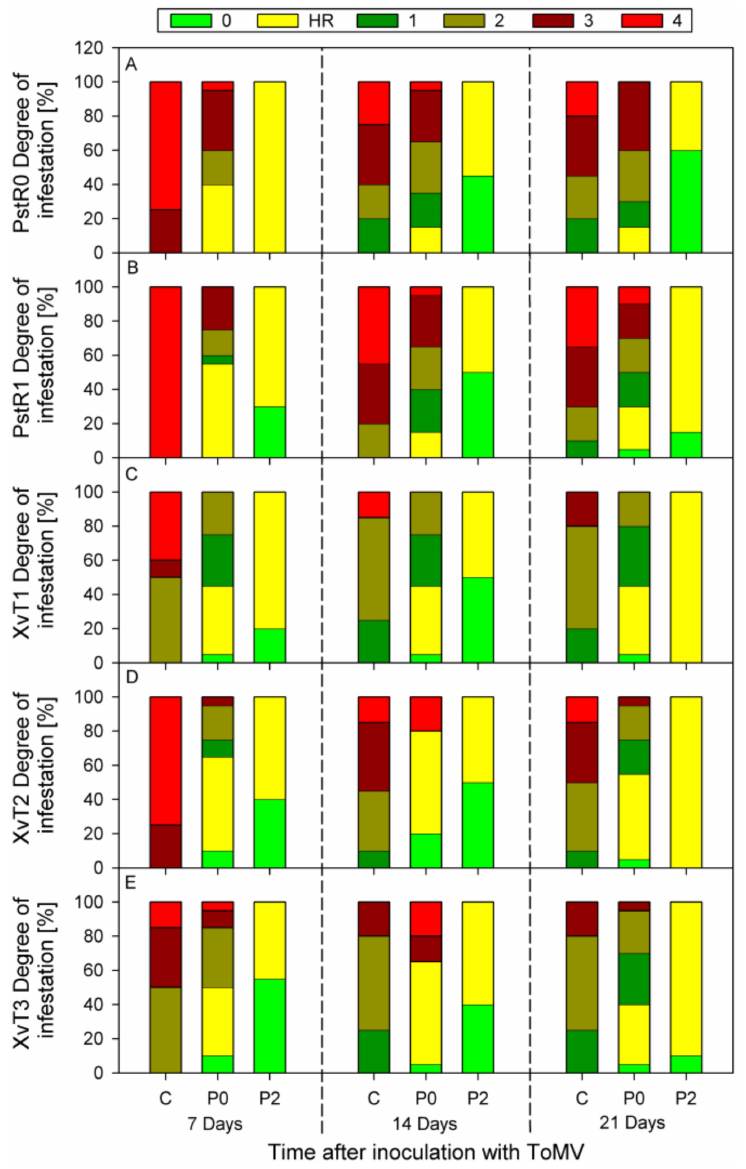
Figure 1. Degree of infestation from Pst (R0, R1) and Xv (T1, T2, T3) on tomato plants cv. Moperou, pre-inoculated with tomato mosaic virus (ToMV) incompatible strain (GM-0) P0 and with compatible (J) strain P2 (7, 14, and 21 dpi). The classification of plants was made on the basis of the mean score of infestation: immune (0); resistant (1); moderately sensitive (2); sensitive (3); and highly sensitive (4). C = Control; HR = Hypersensitive